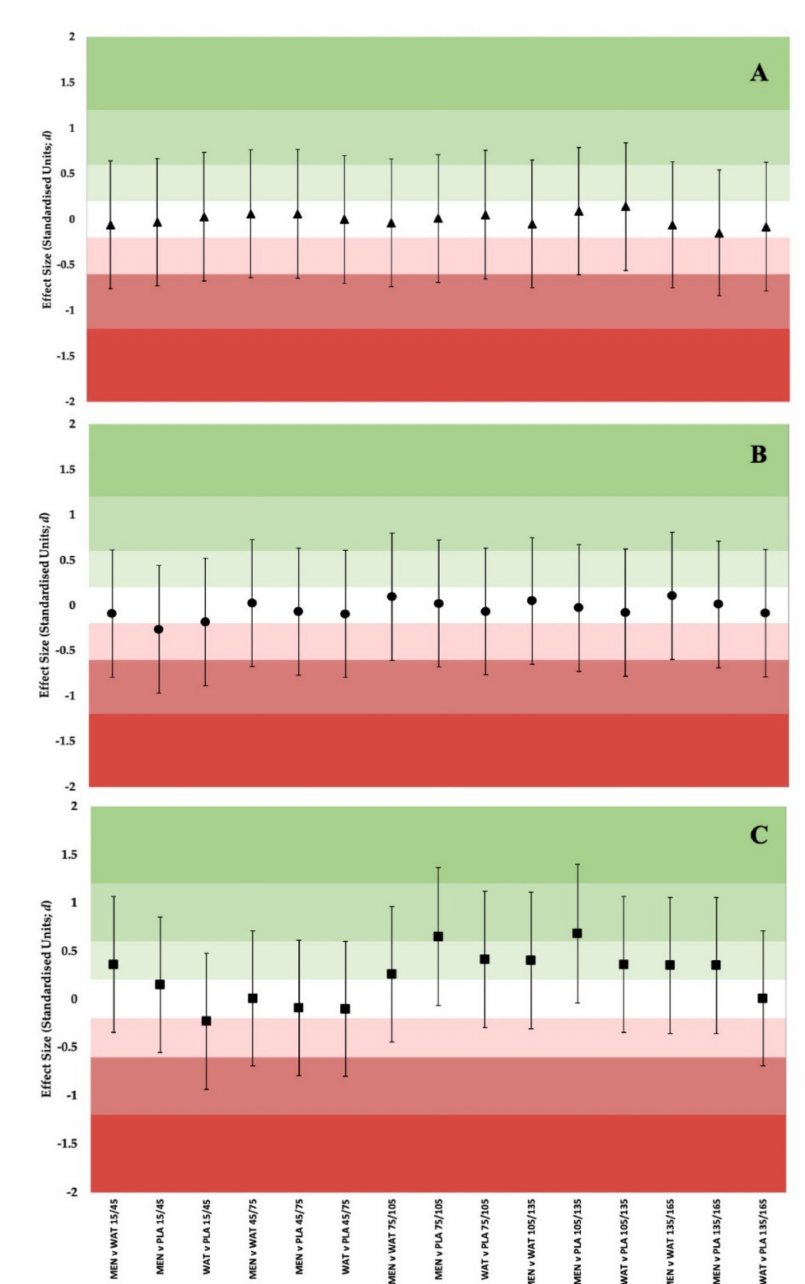
Figure 5. Forest Plot of ES ± 90% CI at matched time points and between solutions for ( A ) VO 2 , ( B ) VE and ( C )